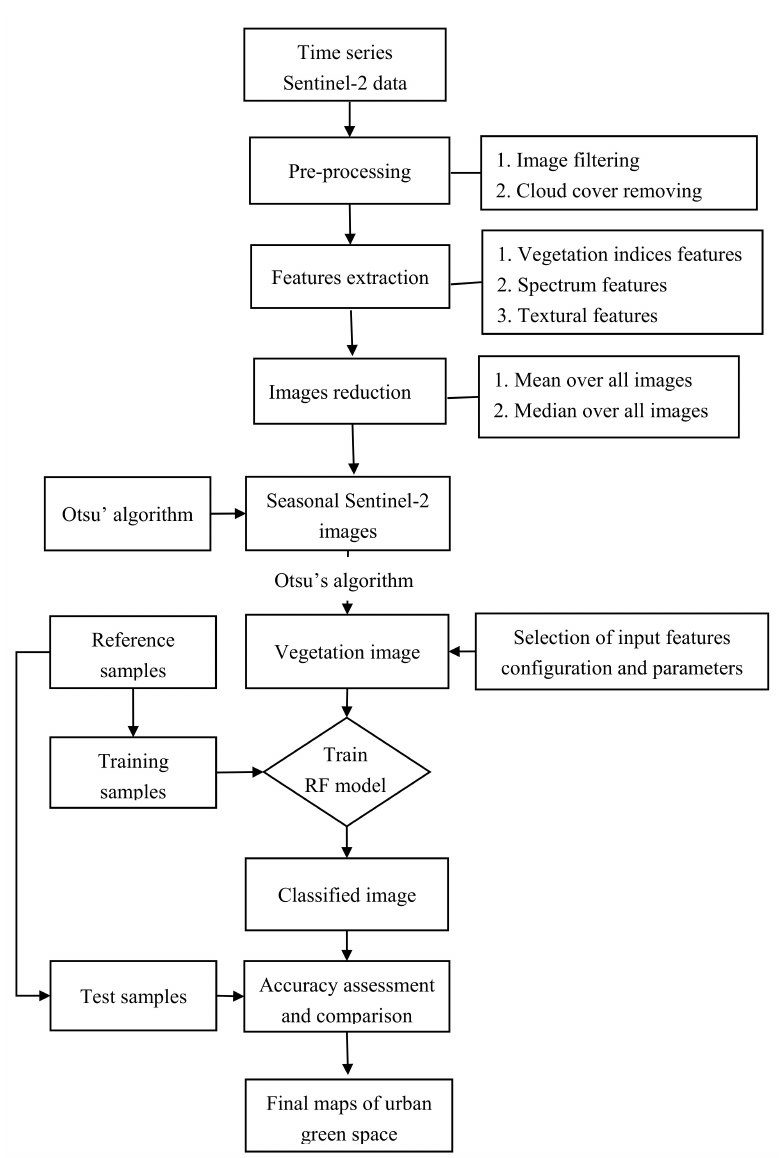
Figure 2. Flowchart of the proposed methodology for UGS classification in